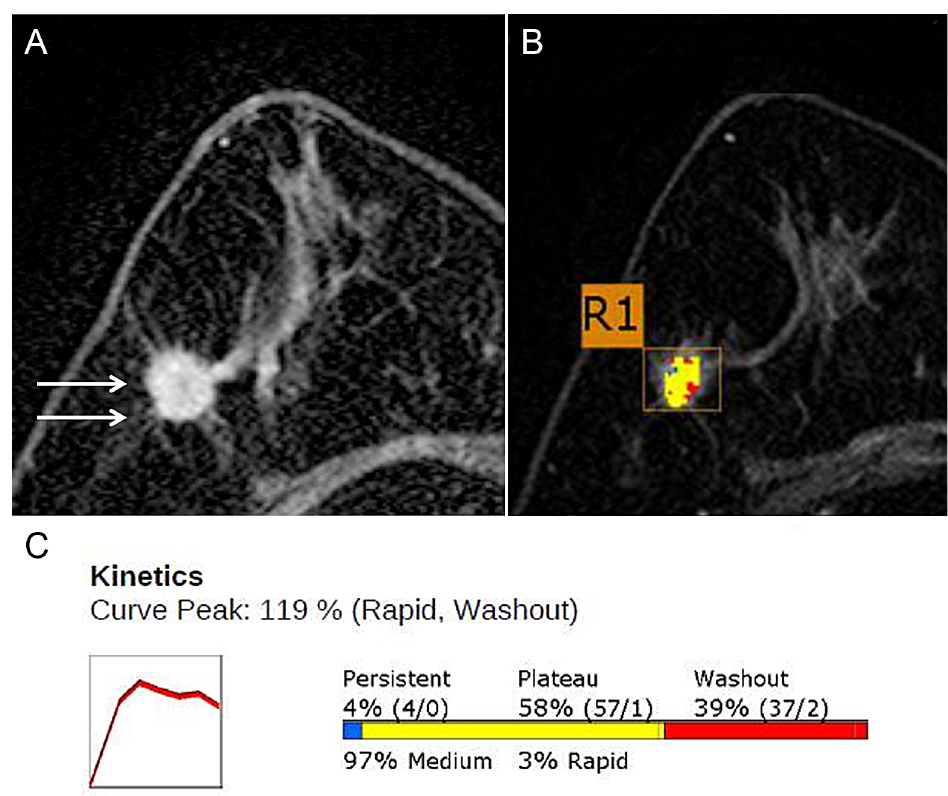
Fig 2. Magnetic resonance (MR) Images with Computer-aided detection (CAD) Color Overlay Map in a 71-year- old Woman with grade 2 invasive ductal carcinoma in the right breast. ( A ) Axial contrast-enhanced T1-weighted MR image shows a 15-mm irregular mass (arrows). ( B ) Axial maximum-intensity-projection MR image shows a CAD color overlay over the breast mass. R1 denotes the first lesion of the right breast. Areas in red, yellow, and blue indicate rapid washout-type delayed enhancement, plateau-type delayed enhancement, and persistent-type delayed enhancement patterns, respectively. (C) Graph of the kinetic curve shows rapid initial enhancement and rapid washout-type curve. The initial peak enhancement value was 119%. With respect to the delayed phase enhancement, 39% of the mass showed washout, 4% of the mass showed a persistent-type curve, and 58% showed a plateau-type curve. There was no recurrence during the 65-month follow-up